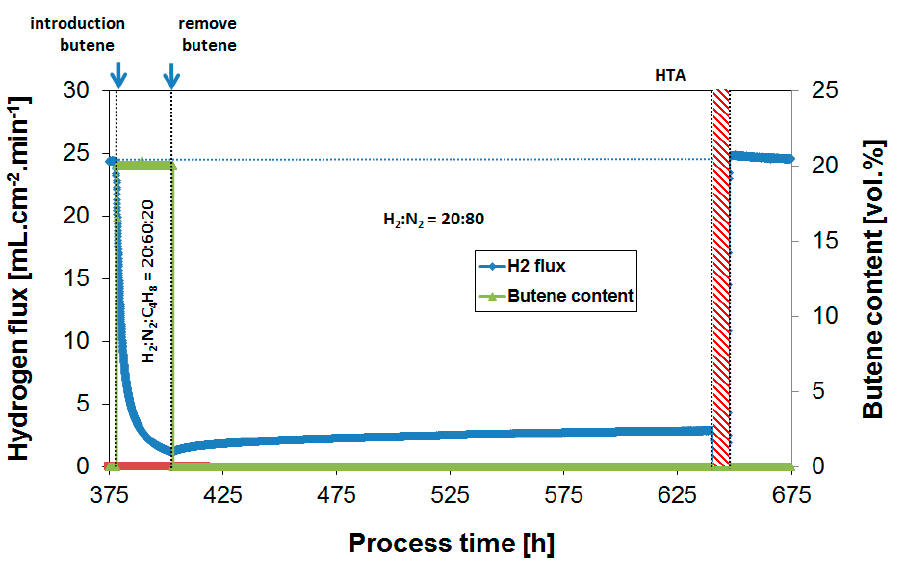
Figure 7. H 2 flux during continuous recovery after butylene exposure (20%) to a feed mixture of H 2 :N 2 :C 4 H 10 = 20:60:20. Subsequent air treatment to regenerate the membrane performance. Temperature = 350 °C.